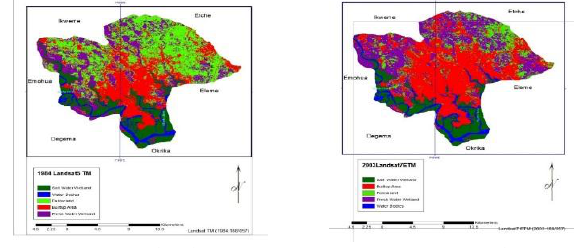
Figure 2: 1984 Landsat5 TM Image Figure 3: 1999 Landsat7 ETM . Image